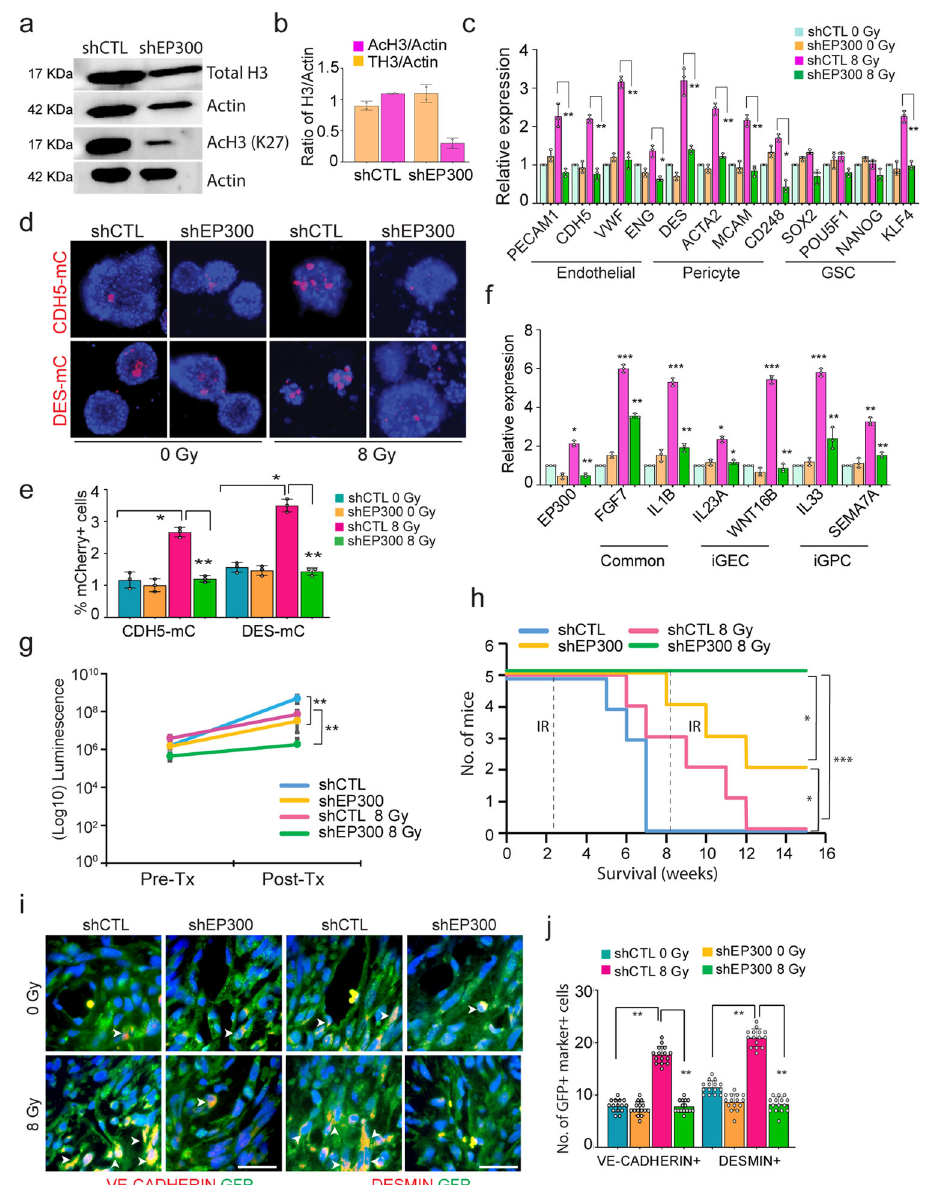
Fig.7|EP300-de fi cientgliomacellsshowreducedvascular-likeconversionand tumor growth post-radiation treatment. a , b Immunoblots of total and AcH3 in EP300-de fi cient(shEP300_A)and control(shCTL)cells. Graphs showsquantitation of protein levels in each condition. c Relative expression of endothelial, pericyte and stem genes in EP300-de fi cient and control cells postradiation. N =3 biological replicates. * and ** indicates p <0.05 and p <0.005, one-way ANOVA and post hoc t-test. d, e mCherry expression in EP300-de fi cient and control cells post-radiation. Flow-cytometricquantitationofmCherry+cellsineachgroup.Errorbarsrepresent mean±SD. N =3biologicalreplicates,*indicates p <0.05and** p <0.005,one-way ANOVA, post hoc t-test. f Relative expression of iGEC- and iGPC-enriched growth